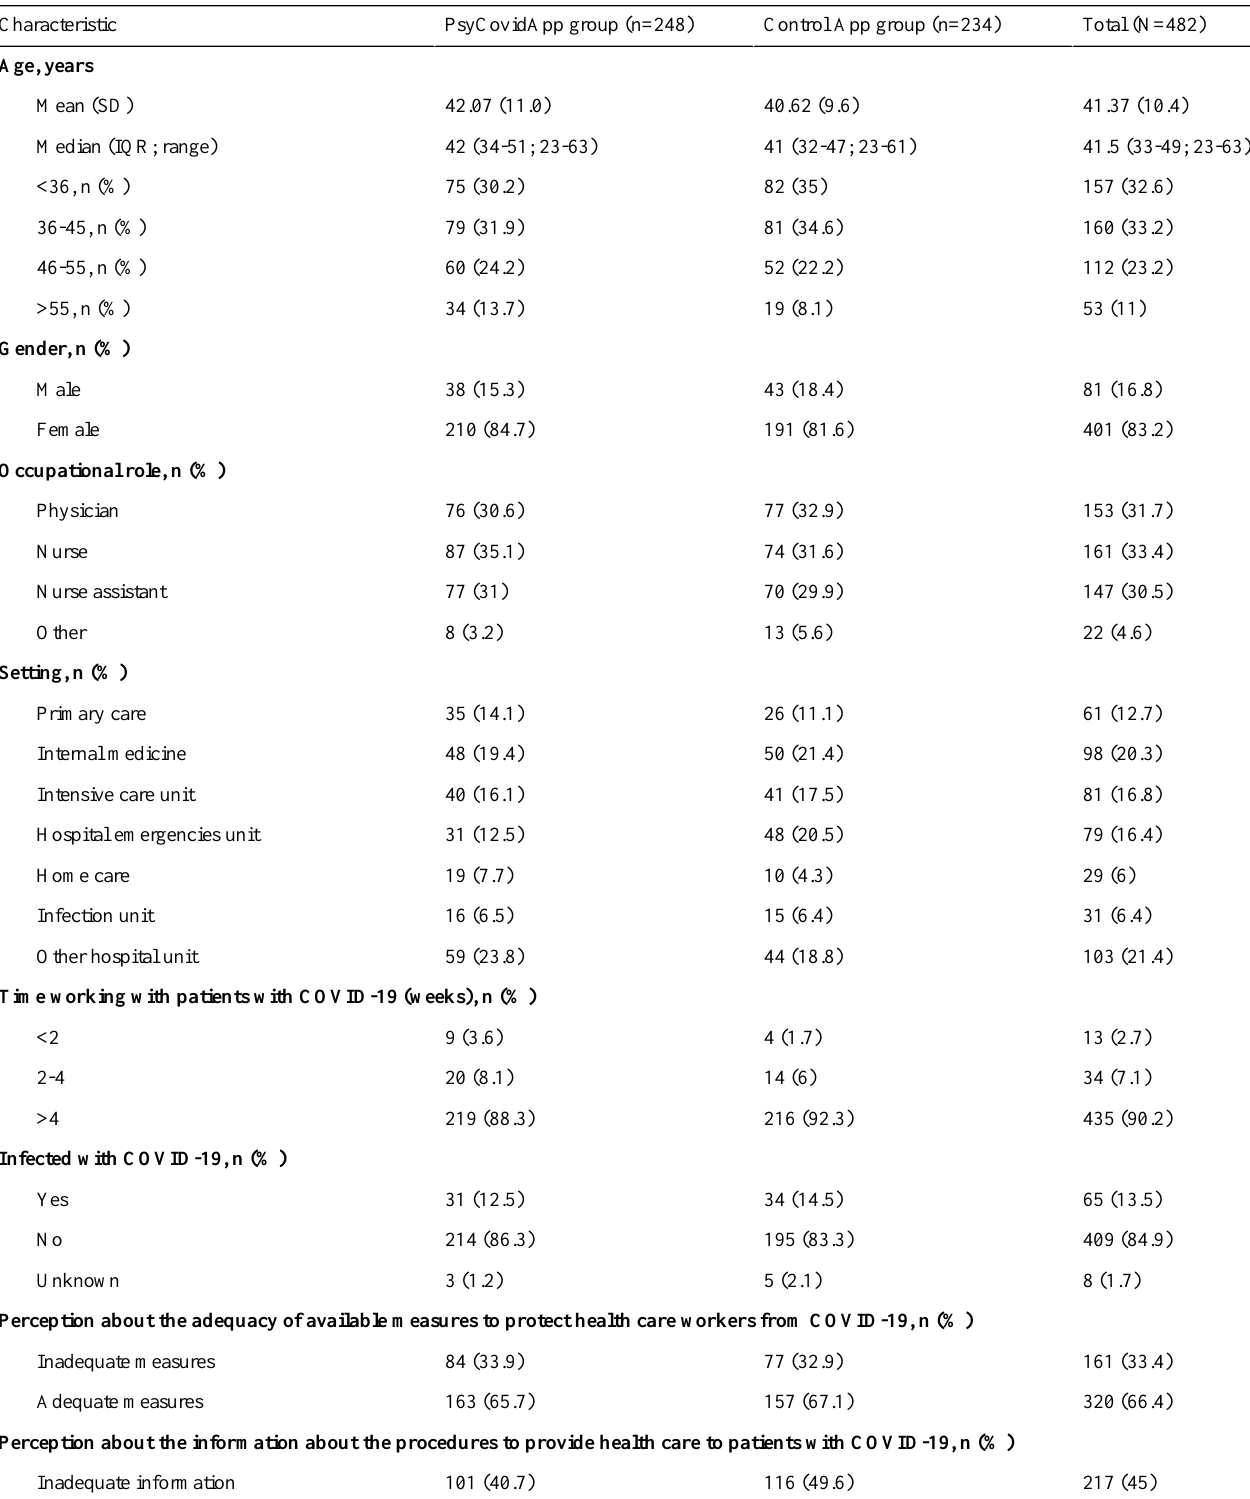
Table 1. Baseline demographic characteristics of the intention-to-treat population